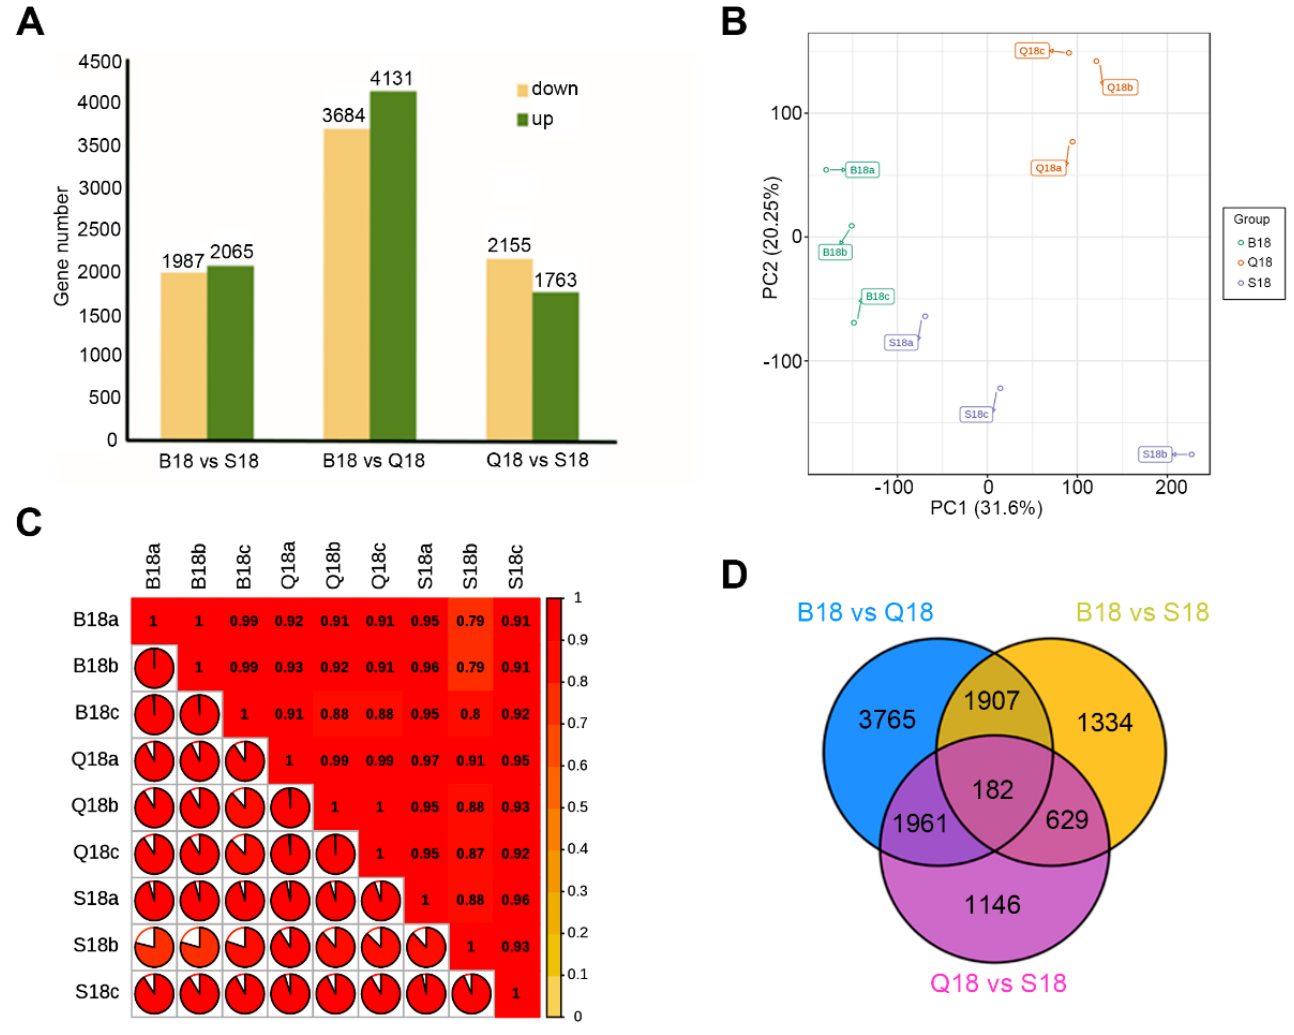
Figure 4. Identification of DEGs between DCF, LCF, and WCF. ( A ) The total number of DEG identified in each comparison. ( B ) Principal Component Analysis of the genes identified from the 9 samples. ( C ) Pearson Correlation Coefficient of the genes identified from the 9 samples. ( D ) Venn diagram showing DEGs between DCF, LCF, and WCF. B18, Q18, and S18 represent DCF, LCF, and WCF at 18DPA, respectively.